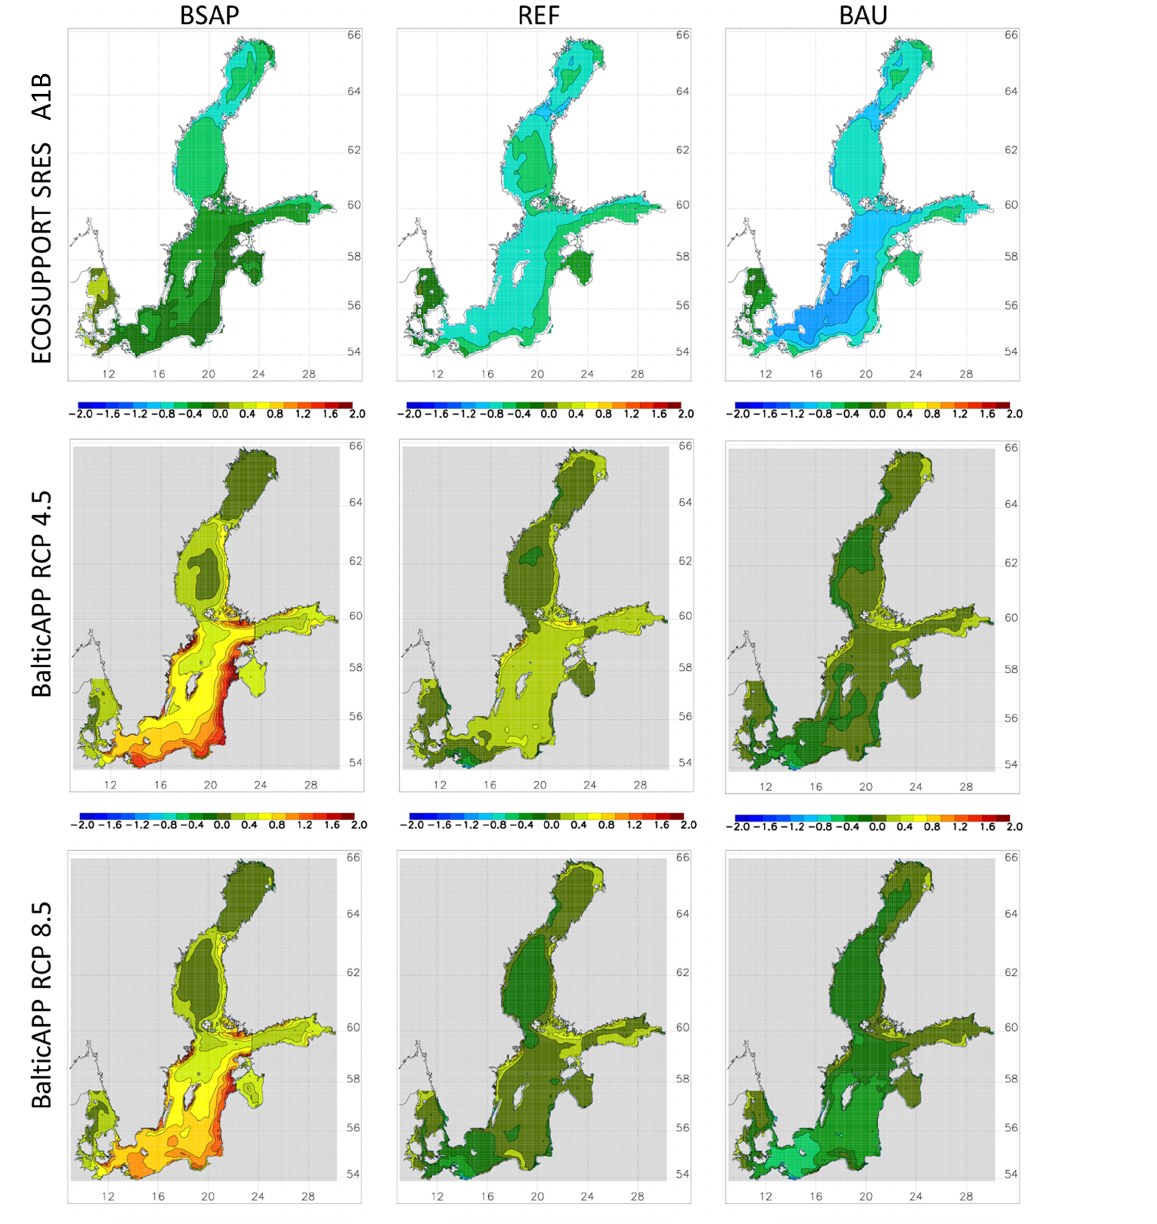
Figure 33. The same as Fig. 32 but for annual mean Secchi depth changes (metres). Secchi depth changes indicate changes in water transparency caused by phytoplankton and detritus concentration changes. Source: Meier et al.,